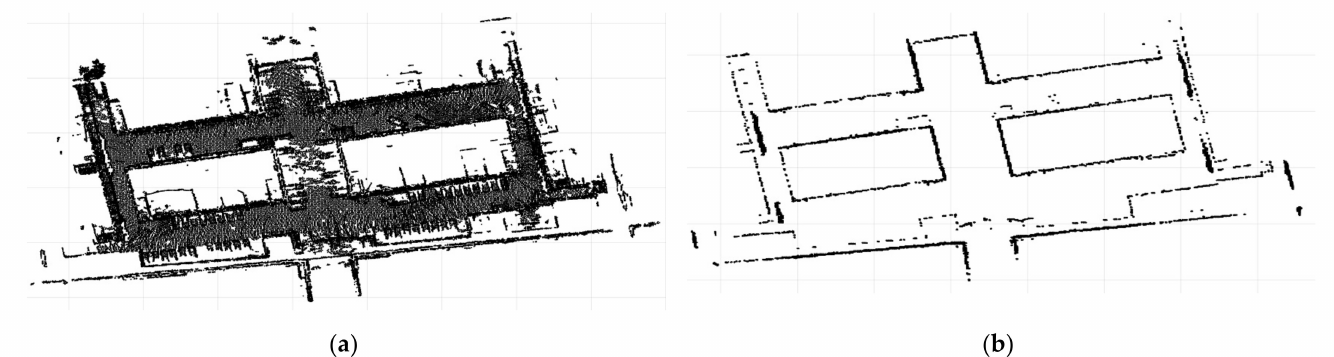
Figure 7. The process of the GPCA algorithm: ( a ) the initial 3D data are mapped to a 2D plane using the PCA algorithm and ( b ) the GPCA algorithm is used to filter the noise of the wall two-dimensional points. The features of the walls are